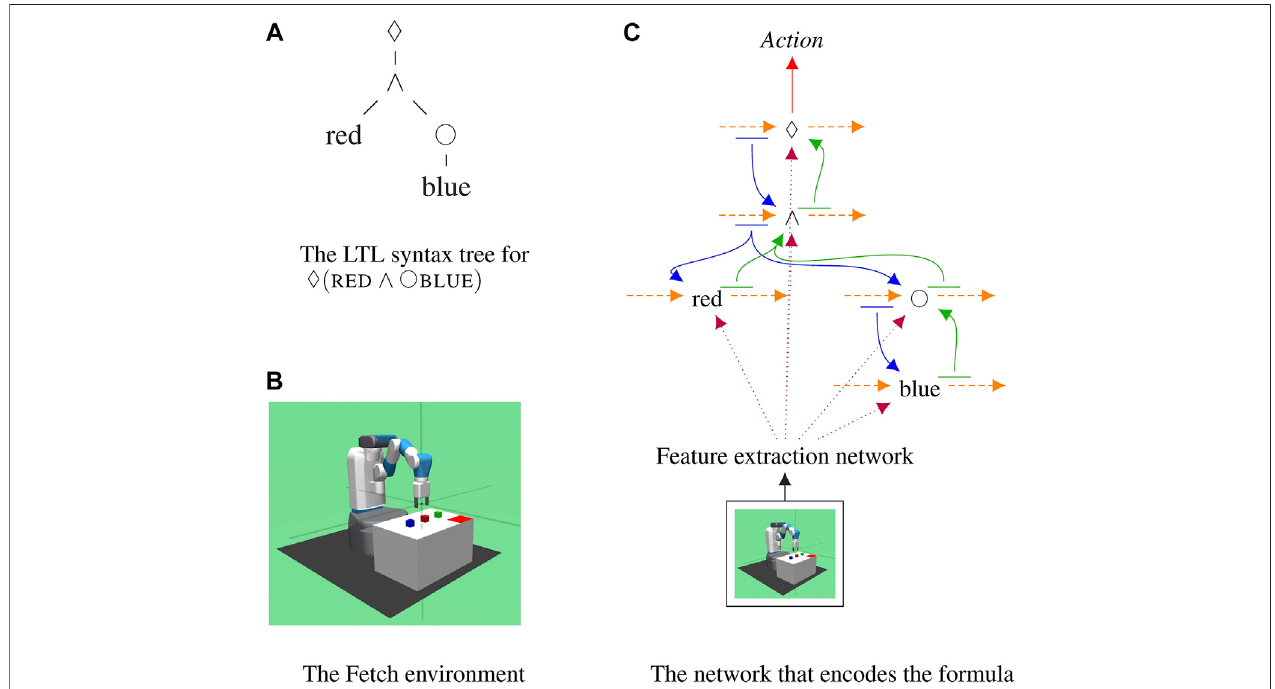
FIGURE 1 | The proposed compositional recurrent network that encodes one formula, ◇ ( red ∧ ○ blue ) . This formula corresponds to a command such as “ Eventually move the red block into the tray and then move in the blue block. ” (A) shows the syntax tree parsed from the formula. This tree provides the structure of the network. (B) is an example con fi guration of the Fetch domain, the Fetch robot is trained to move blocks of different colors in and out of the tray (i.e., the red rectangular area on the table). (C) shows the internal structure of the composed network.